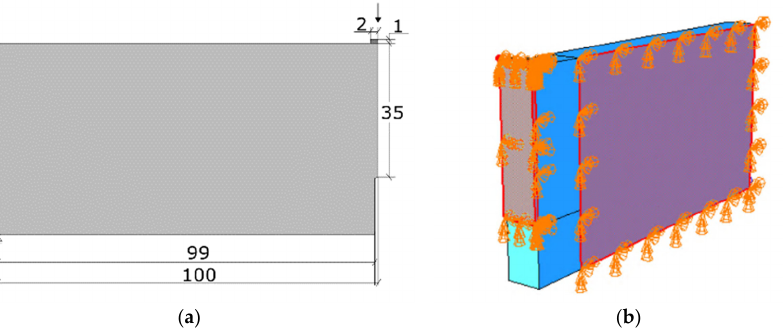
Figure 9. Geometry ( a ) and symmetric boundary conditions ( b ) of the three-point bending beam.